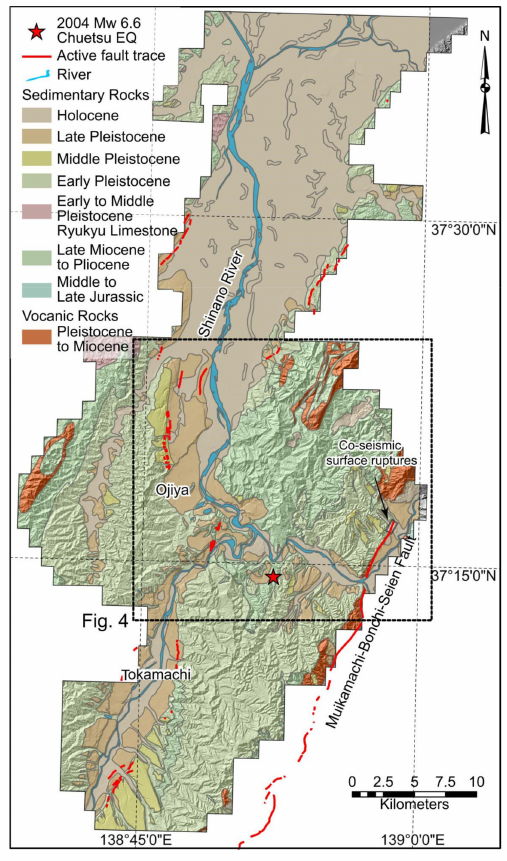
Figure 2. Geological map of the epicentral area of the 2004 Chuetsu earthquake. The red lines show the major active faults. The small rectangle shows the location of the co-seismic surface rupture of the 2004 Chuetsu earthquake, which occurred on the northward extension of the Muikamachi fault zone